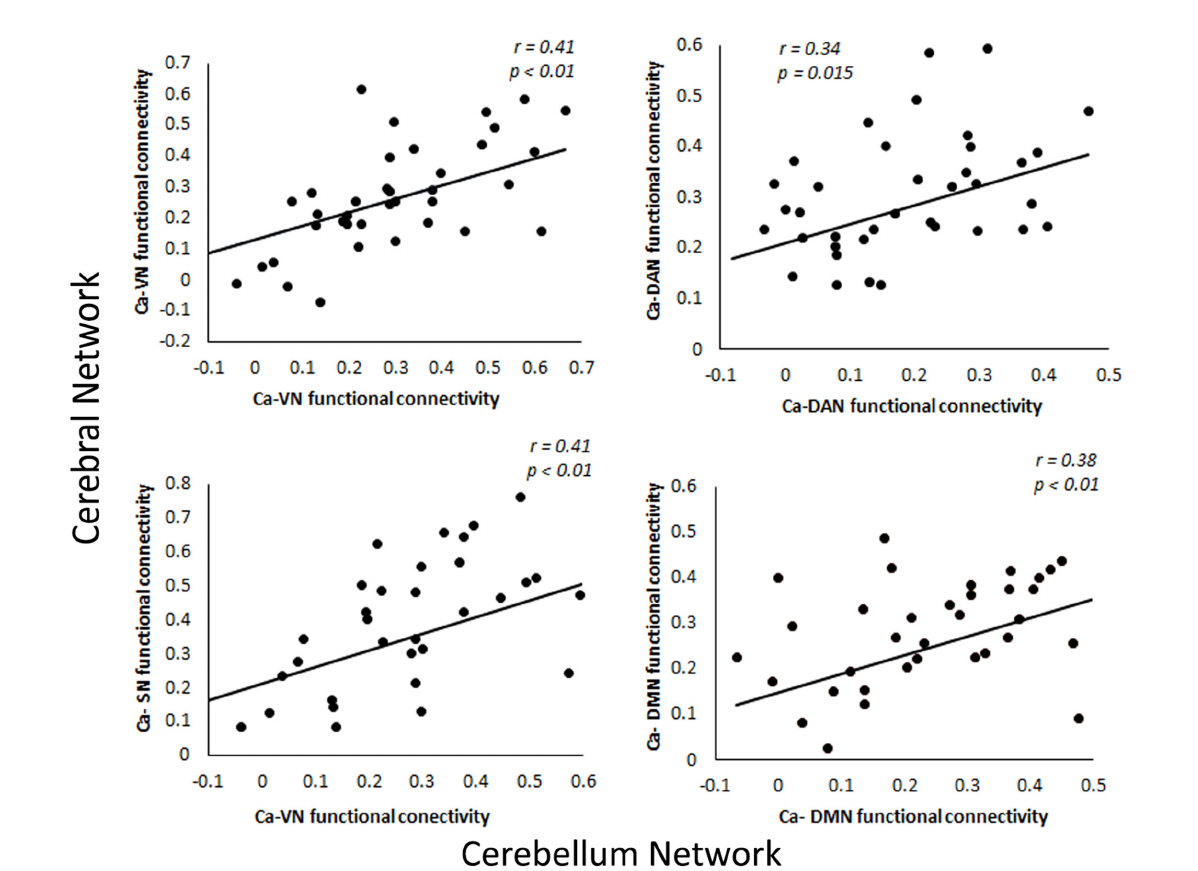
FIGURE4 Relationship between functional connectivity of caudate in cerebral and cerebellar networks. VN, Ventral Network; DAN, Dorsal Attention Network; SN, Somatomotor Network; DMN, Default Mode